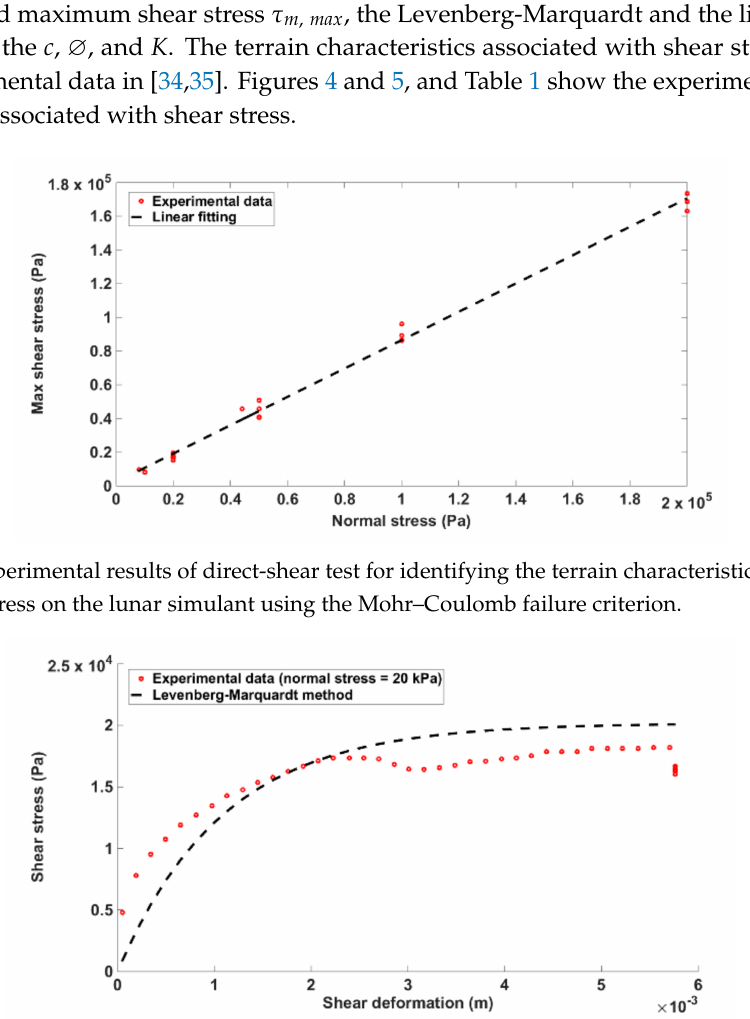
Figure 5. Experimental results of direct-hear test for identifying the terrain characteristics associated with shear stress on the lunar simulant using the Janosi–Hanamoto